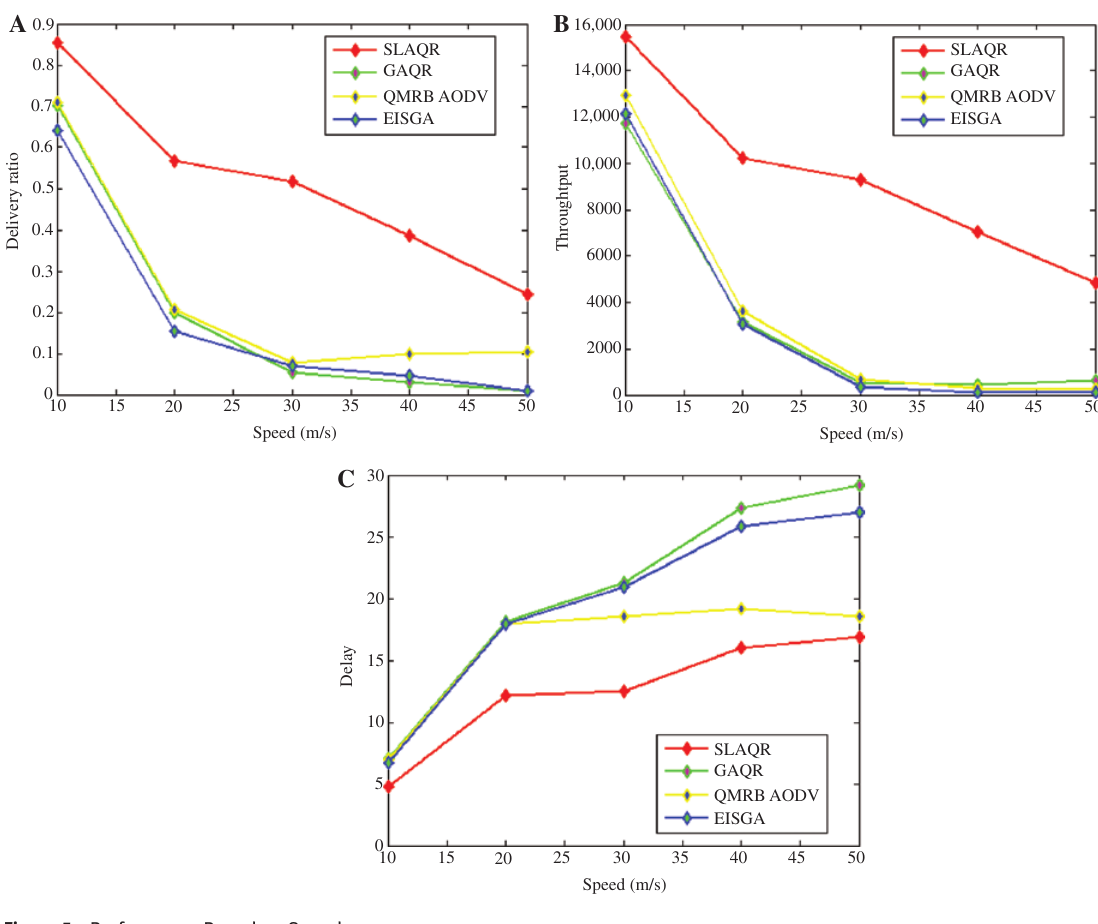
Figure 5: Performance Based on